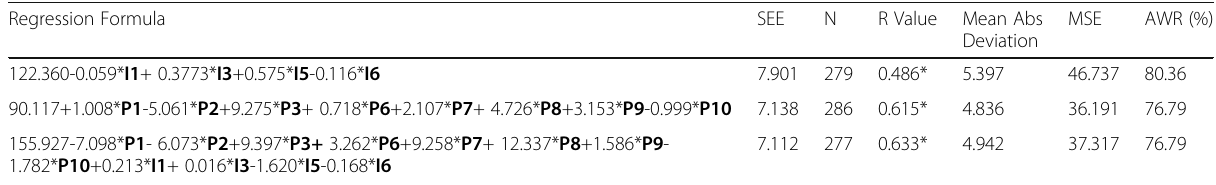
Table 8 Correlation and regression statistics for combination of parameters and indexes of sacral morphometric against stature in validation